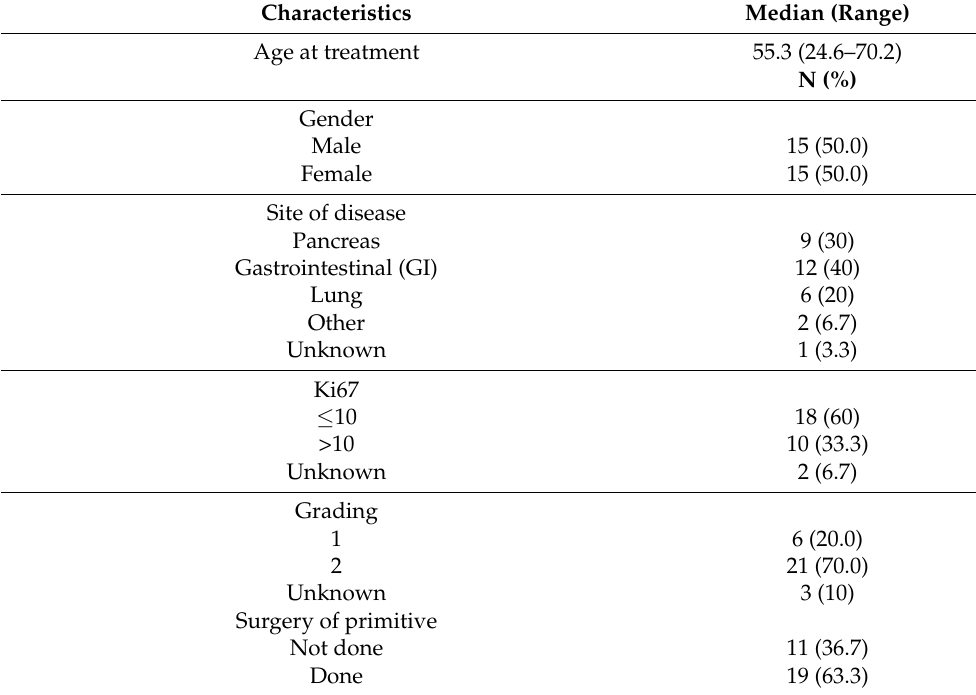
Table 1. Patient